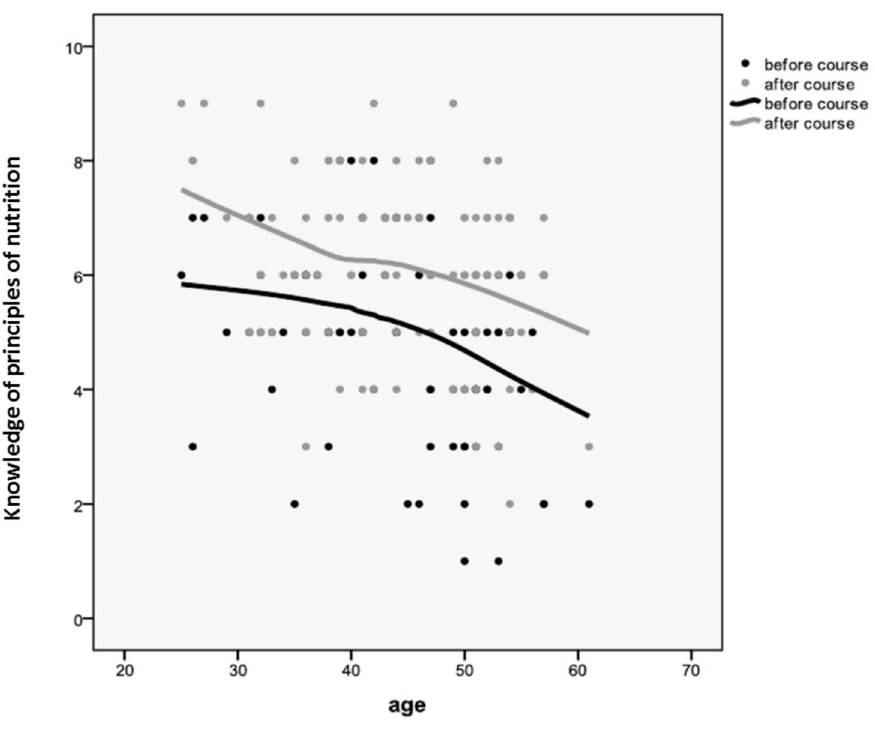
Figure 3b. Scatter plot for age and knowledge of principles of nutrition by time of test (including LOESS fit